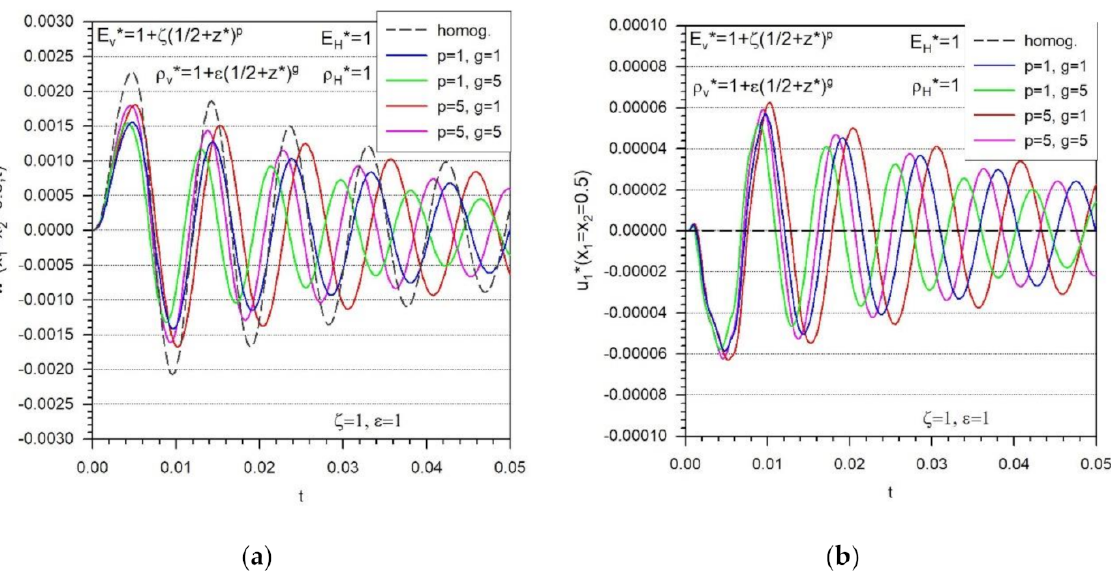
Figure 10. Influences of the gradation exponent of the mass density ( g ) and/or the elastic mod- ulus ( p ) on the time variation of: ( a ) the dimensionless central deflection, ( b ) the dimensionless in-plane